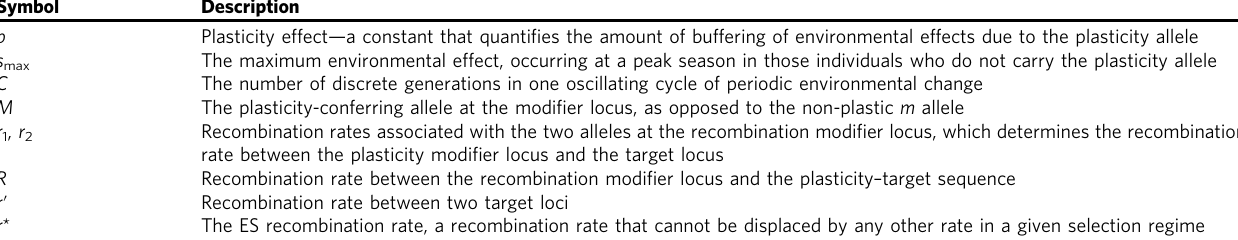
Table 1 Common symbols and terms used in the text Symbol